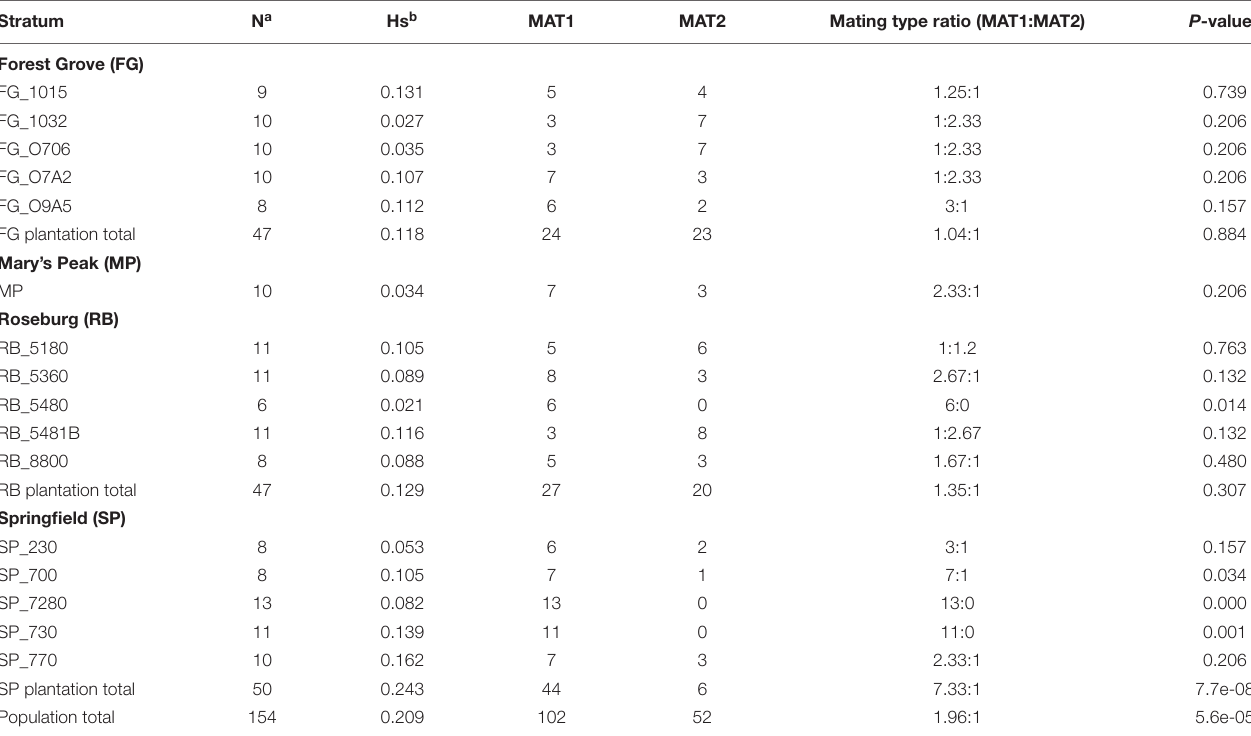
TABLE 2 | Sample sizes, expected heterozygosity, and inferred mating type ratios for the stands and planations from which Leptographium wageneri var. pseudotsugae isolates were collected. Stratum N a Hs b MAT1 MAT2 Mating type ratio (MAT1:MAT2) P -value c